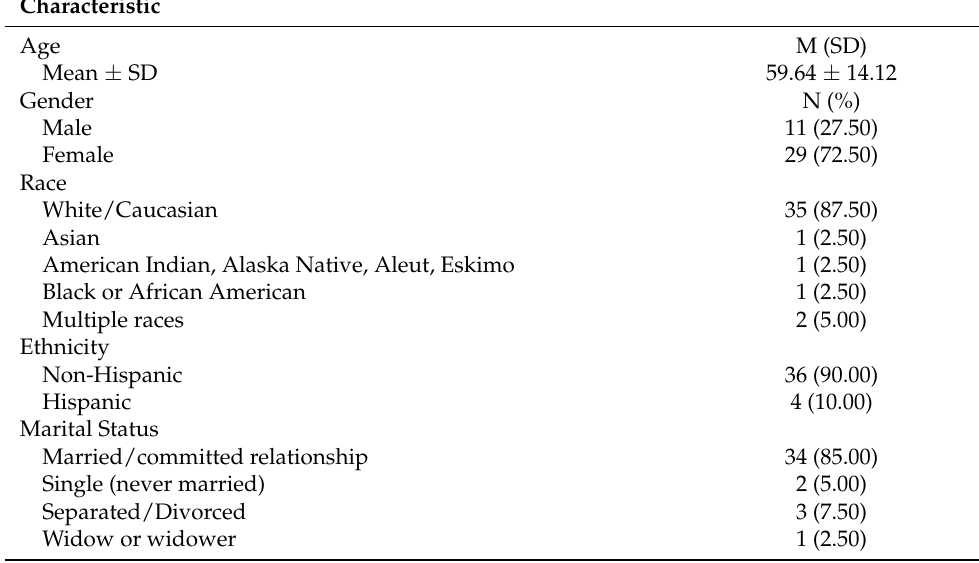
Table 1. Demographics of Caregivers (n =